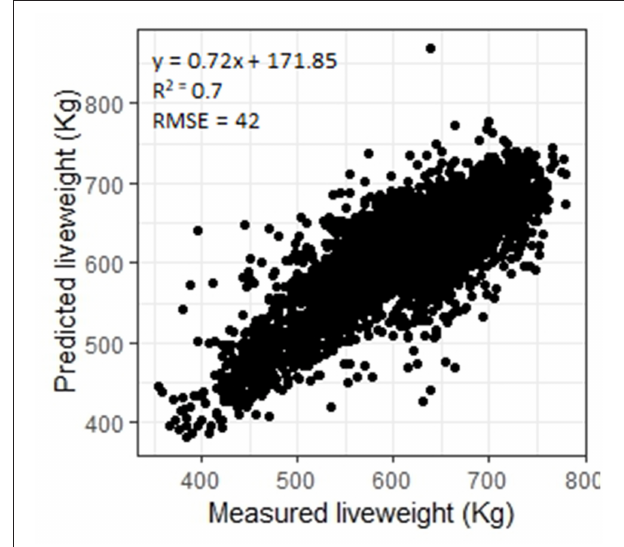
FIGURE 2 | Measured liveweights plotted against liveweights predicted using an artificial neural